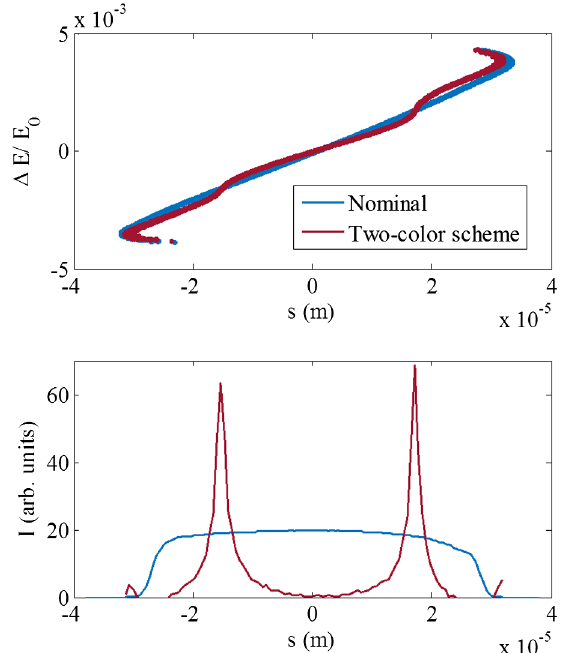
FIG. 2. Comparison of the beam longitudinal phase space at the entrance of BC1 (top) and current longitudinal profile at the entrance of BC2 (bottom) corresponding to the nominal operation mode of SwissFEL and the one assuming an opportune wakefield